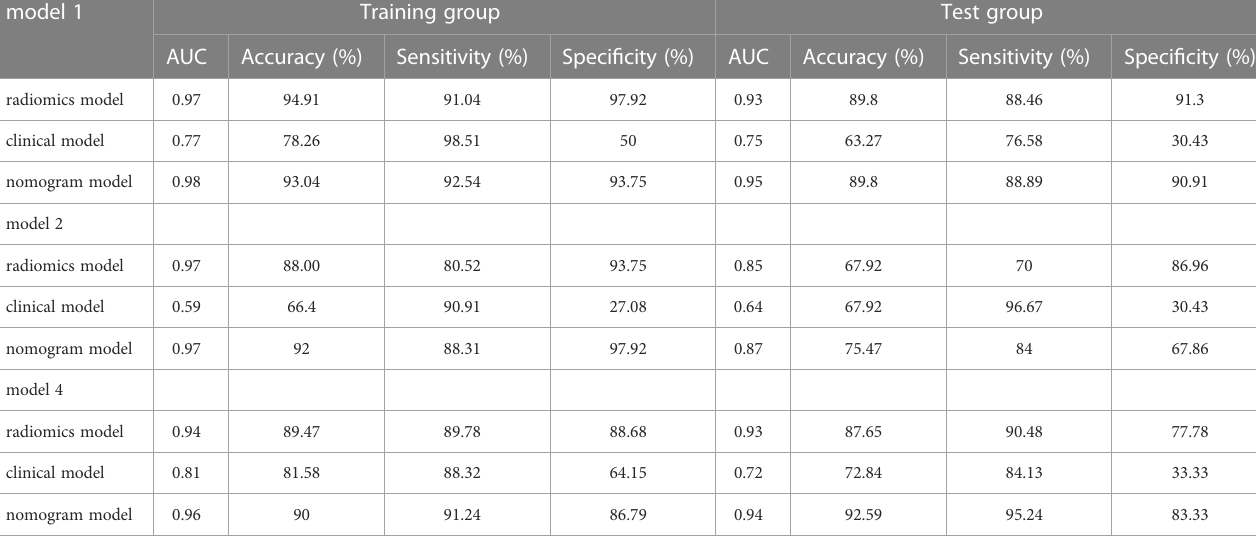
TABLE 3 Diagnostic ef fi cacy of radiomics model, clinical model, nomogram model of model 1, 2, 4. model